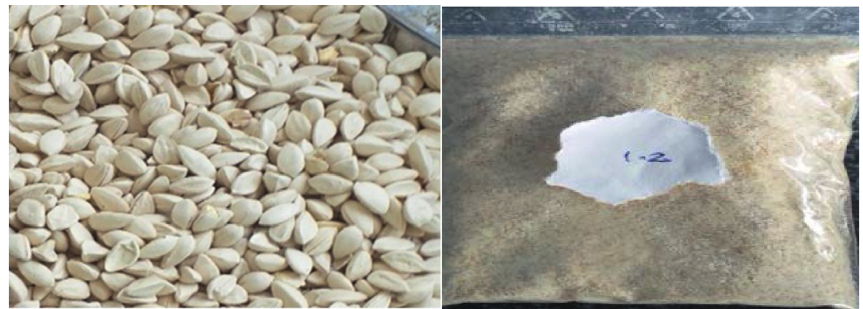
Figure 1: A seed sample of Moringa stenopetala